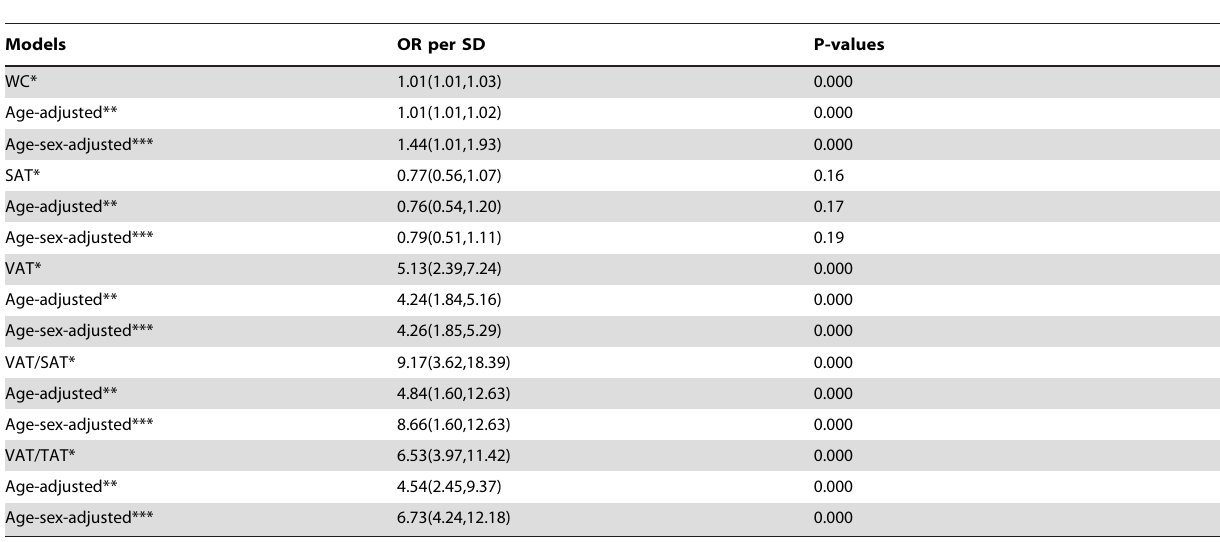
Table 4. Association of different measurements of abdominal fat and distribution proportion of abdominal adipose tissue with